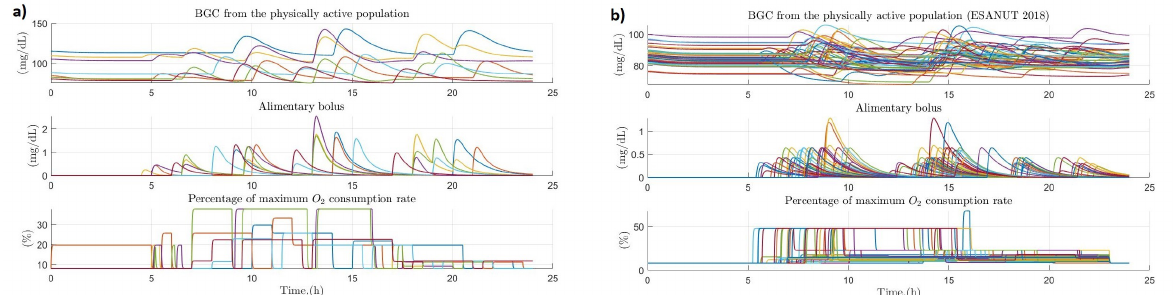
Figure 7. Effect of primary and secondary factors on blood glucose in physically active populations. ( a ) Effect of diet and physical activity on blood glucose concentration in physically active persons (sample of 20 healthy persons); ( b ) Effect of diet and physical activity on blood glucose concentration in physically active people (ENSANUT 2018